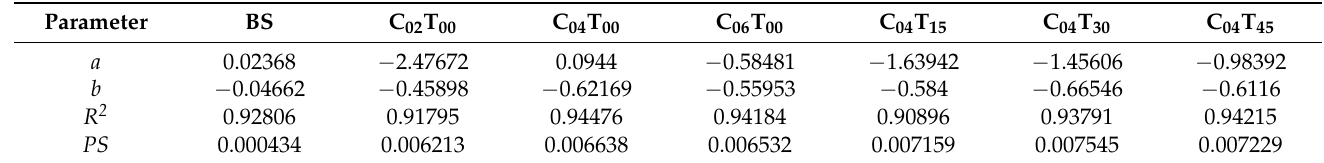
Table 6. Fitting curve parameters of cement-based composites before freeze-thaw cycles.